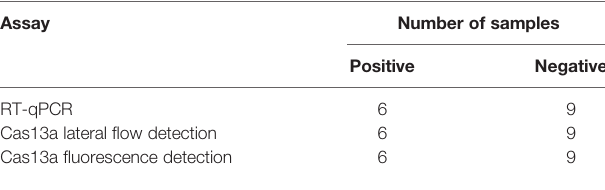
TABLE 2 | Detection results of clinical samples in Cas13a lateral fl ow detection, Cas13a fl uorescence detection, and RT-qPCR assays.